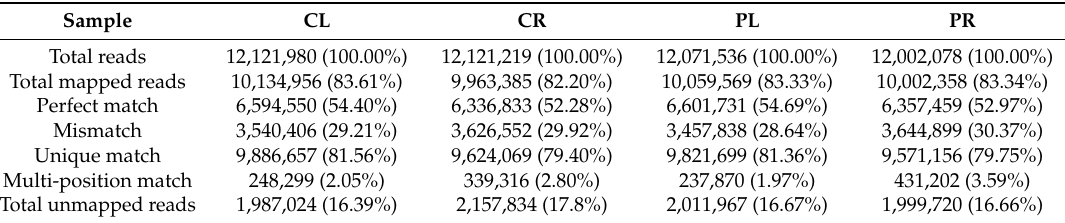
Figure 1. Phenotypic and physiological responses of banana to low P stress. ( A ) Banana seedlings were treated with low P conditions for 0, 20, 34, 48 and 60 days, a, WT, b, phosphorus deficit stress ( − P) treatment; ( B ) Total leaf number, number of symptomatic leaves, fresh weight of leaves, fresh weight (g) of roots, dry weight of leaves, and dry weight of roots; ( C ) P concentrations (mg/g) in aboveground parts and roots. There were 20 replicates for each treatment, and the error bars show means ± Standard Deviation. The different letters in ( B , C ) indicate a significant difference by T test ( p < 0.05) using SPSS statistical software. Table 1. Statistical analysis of clean reads mapped to the reference genome.